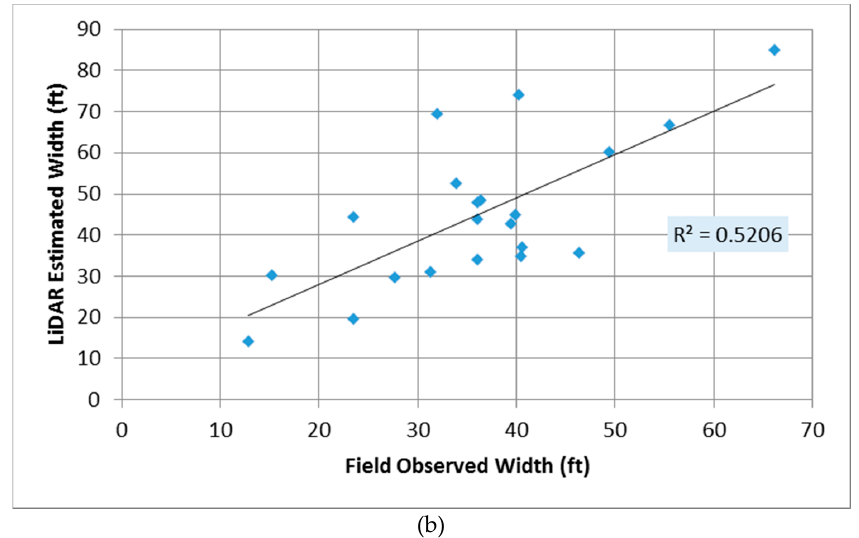
Figure 5. ( a ) Three transects for validation and ( b ) validation of field observed tree width (along N-S direction) versus LiDAR Estimates.